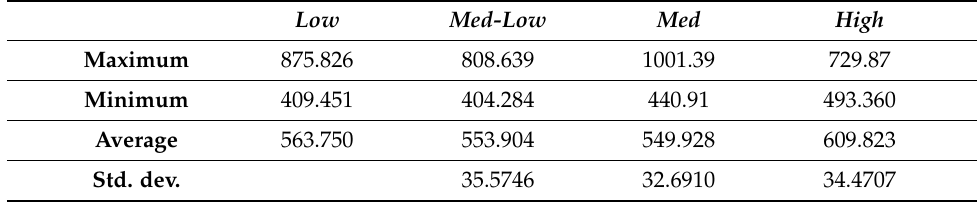
Table 5. Dispersion measures for cost 1 .